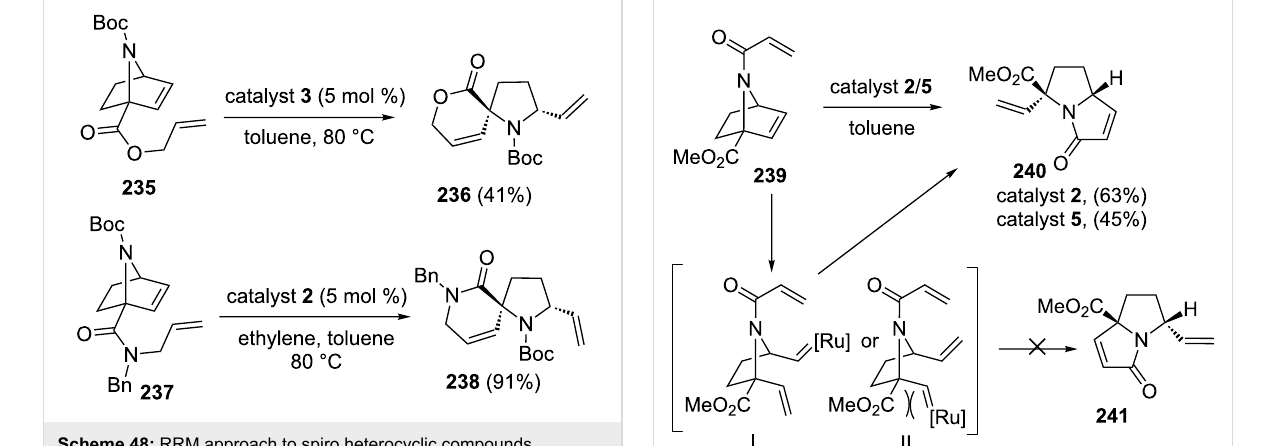
Scheme 48: RRM approach to spiro heterocyclic